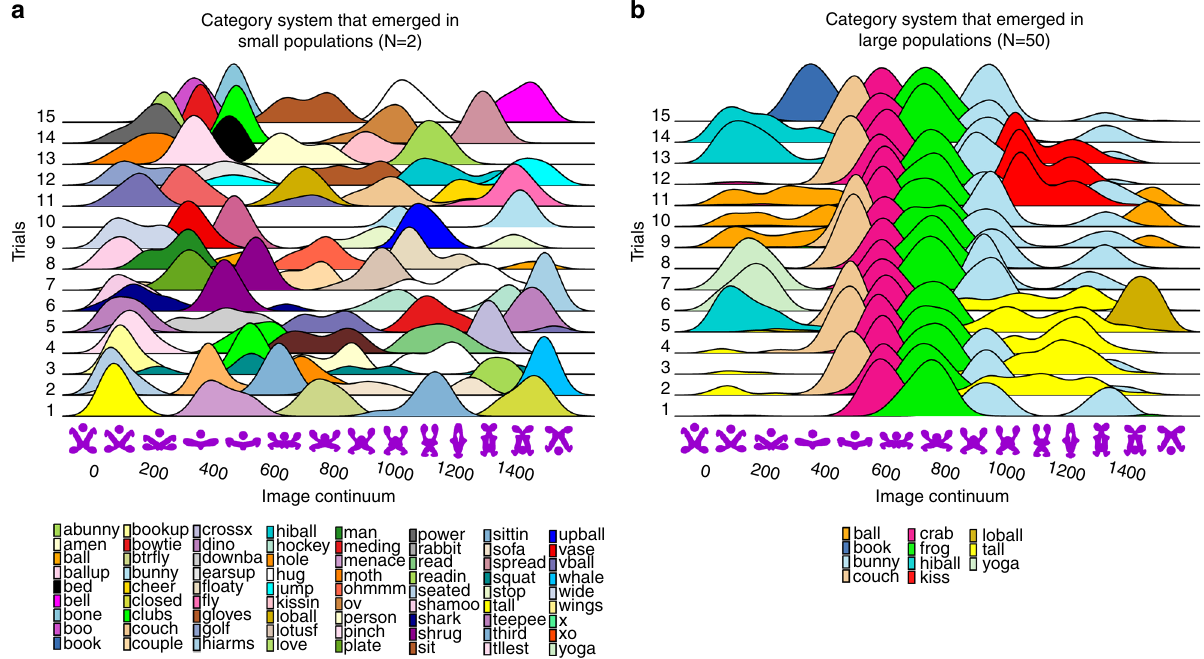
Fig. 1 Larger populations promote category convergence across populations. Comparing the level of convergence in category systems that emerged in small ( N = 2) ( a ) and large ( N = 50) ( b ) populations. Each row displays the category system constructed by a single unique population in each condition after 100 rounds of interaction. The horizontal axis displays the image continuum of shapes, consisting of 1500 slices. Density distributions display the frequency of successful coordination for each label, as well as the region of the continuum to which each label referred. Each color indicates a unique label. Similarity in the category systems across independent populations indicates